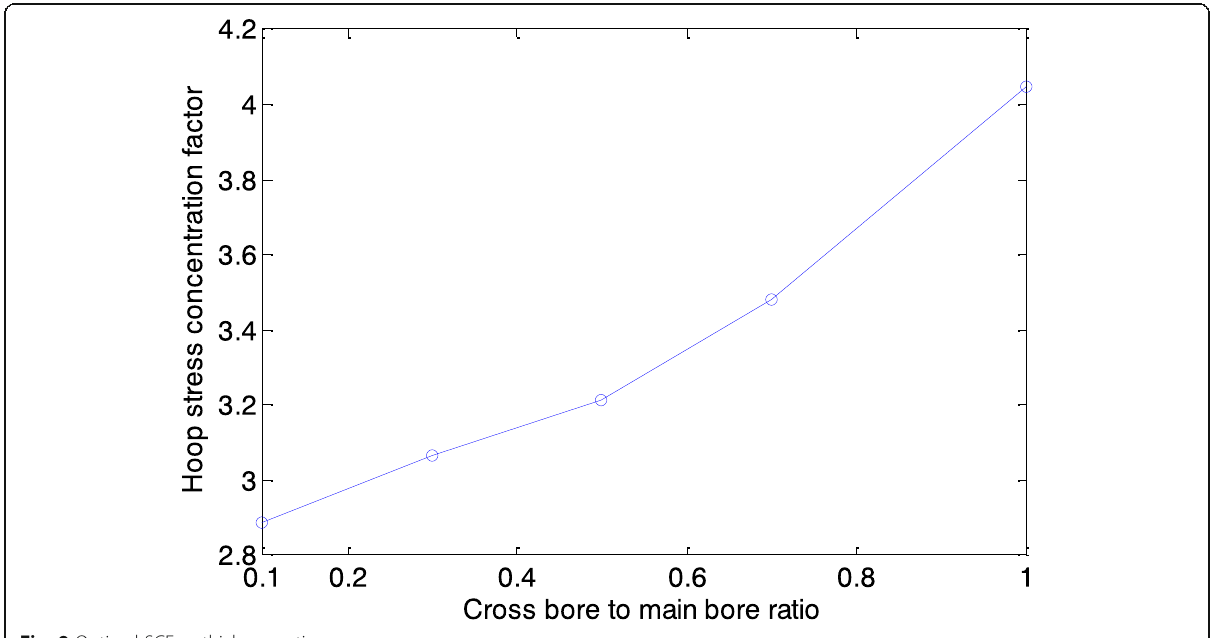
Fig. 9 Optimal SCF vs thickness